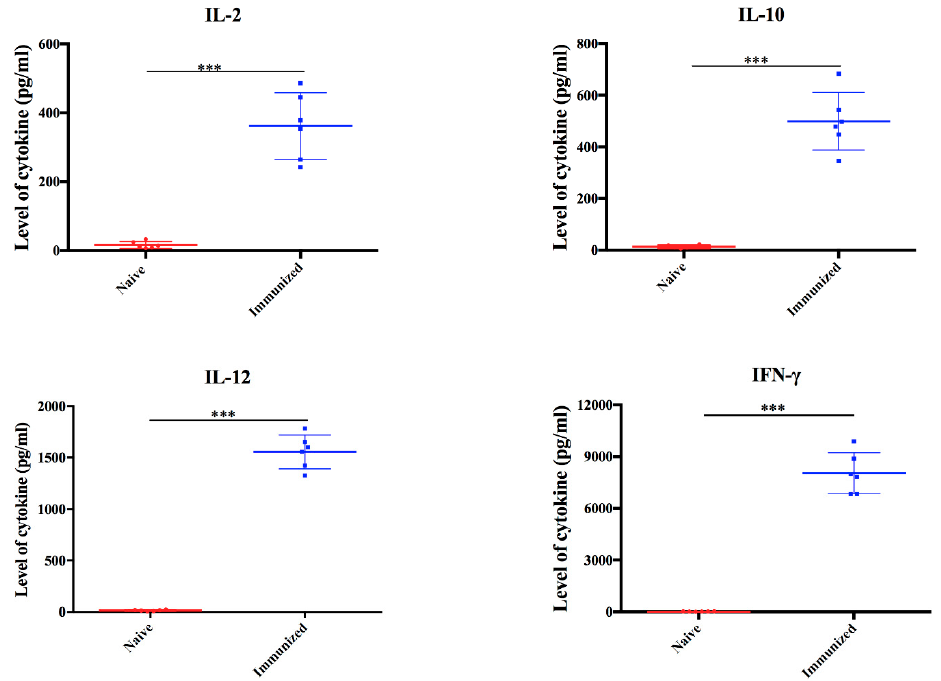
Figure 5. The levels of cytokines detected in the supernatant of splenocyte cultures of RH ∆ gra17 ∆ npt1 -vaccinated mice. Spleen cells were harvested from vaccinated and naïve mice at 60 days post-immunization and stimulated in vitro with 10 µ g / mL STAg. Evaluation of Th1 (IL-2, IL-12 and IFN- γ ) and Th2 (IL-10) cytokines in the splenocyte culture supernatants was performed using ELISA. Data points are represented as means ± SD. A statistically significant difference is indicated by ***, p < 0.001.